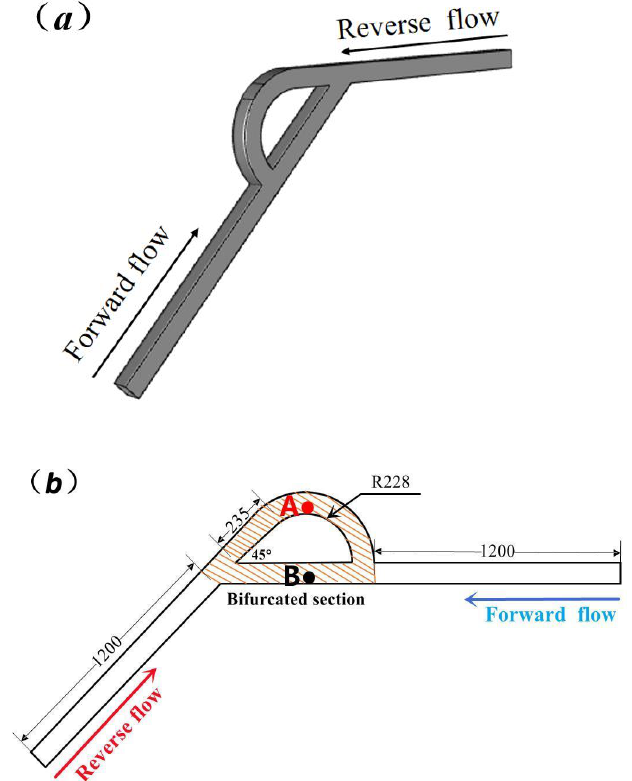
Figure 2. ( a ) 3D geometric model of a T45-R type Tesla valve and ( b ) simplified 2D micro-scale T45- R Tesla valve geometry used in this article (unit: μm) . In the figure ( b ) Point A and B are selected deposition points. deposition